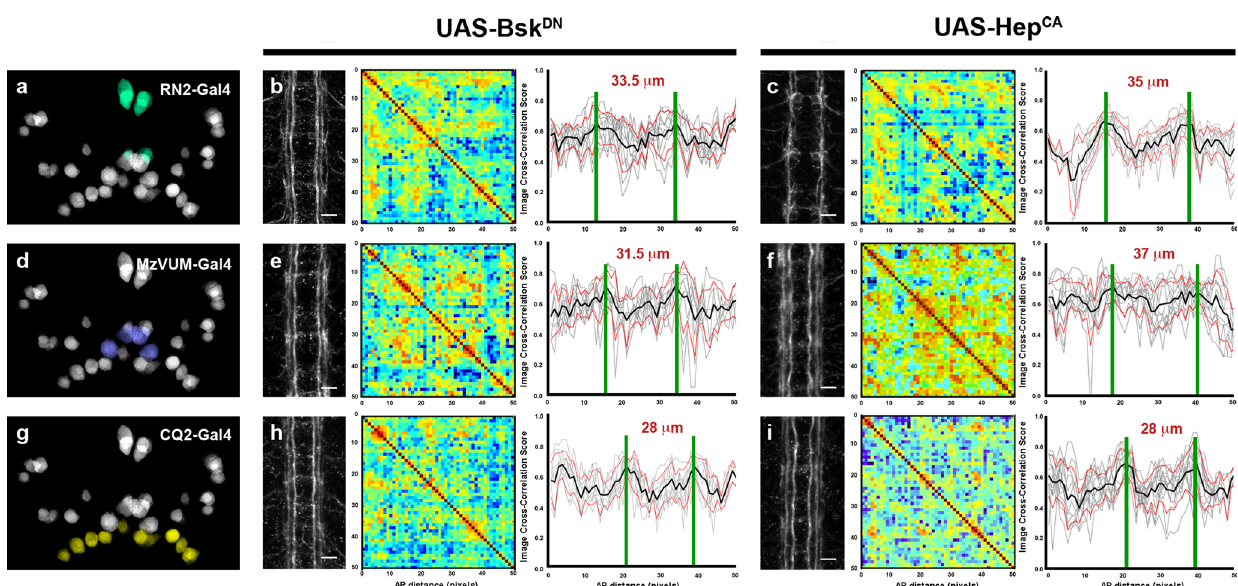
Fig. 3 | Targeted activation and inhibition of the JNK pathway in the VNC. a Cartoon representing the full set of puc expressing neurons per segment in the VNC,highlighting cellsexpressing RN2-Gal4 (turquoise).From left to right, pattern of Fas 2 expression, self-cross-correlation matrix and image cross-correlation pro fi les (scales and colormap as in Fig. 1) for VNCs of 16-stage embryos upon expression of UAS-Bsk DN b and UAS-Hep CA c transgenes, under the control of the RN2-Gal4 respectively, inhibiting and hyperactivating JNK activity in the aCC, pCC and RP2 cells. In this condition connectives defasciculation and 3D nodes cross- correlation pro fi les are affected. Grey lines show individual pro fi les. Black line corresponds to average, with red lines ± SD. Green bars indicate positions of maximum correlation (3D nodes) along the AP axis. Distances between nodes are